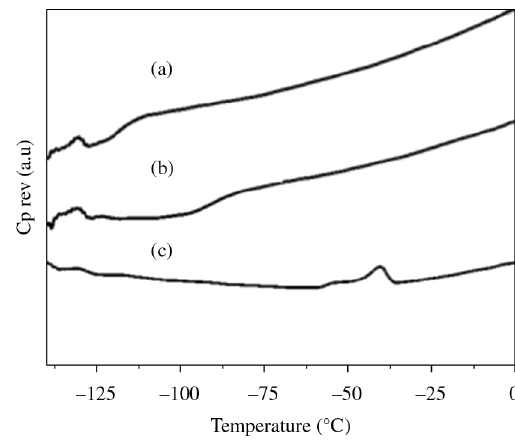
Figure 2. MDSC curves of electrolytes containing PVDF/ LiClO